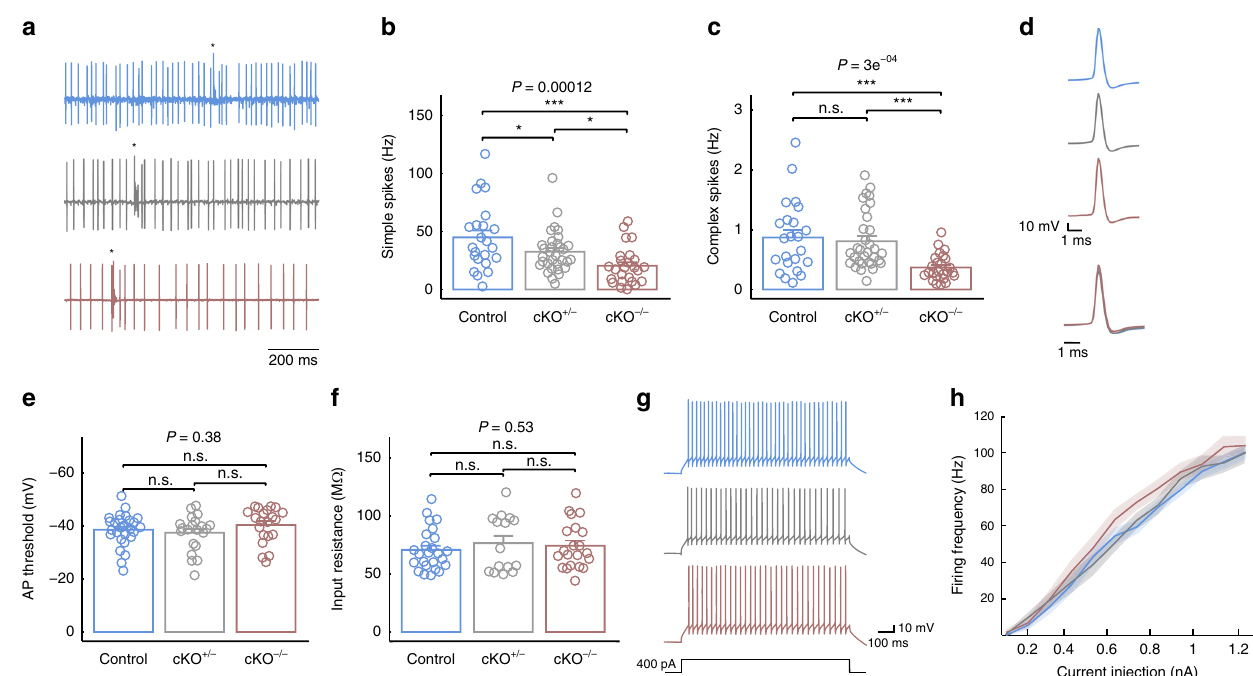
Fig. 6 Pogz -de fi cient mice show reduced spontaneous fi ring frequency of Purkinje cells while the PC intrinsic properties are unaffected. a Single unit activity recorded from PCs in lobules V − VI of the cerebellum. Asterisks indicate complex spikes. b , c Spontaneous fi ring frequency of SS ( b ) and CS ( c ) of all genotypes ( n {cells/animals} = 23/5 control (blue), 32/5 cKO + / − (gray), 25/3 cKO − / − (red). d AP shape for all genotypes. In the bottom is the superpositioned normalized AP. e AP threshold of PCs of all genotypes. n = 28/3 control, 21/2 cKO + / − , 21/2 cKO − / − . f Input resistance of PCs. n = 25/3 control, 15/2 cKO + / − , 21/2 cKO − / − . g The response of PCs of all genotypes to 400 pA current pulse injections. h The average current-to- fi ring frequency ( I − f ) curve of all genotypes. Shaded area indicates SEM. Repeated-measures ANOVA; n = 28/3 control, 21/2 cKO + / − , 21/2 cKO − / − . The P values at the top of the plots are for association between the quantitative measurements and the number of intact Pogz alleles calculated with a linear regression model. Pairwise comparisons between genotypes were calculated by two-tailed t test and the signi fi cance is represented by * P < 0.05; *** P < 0.001; n.s. not signi fi cant. Quantitative data are mean ±